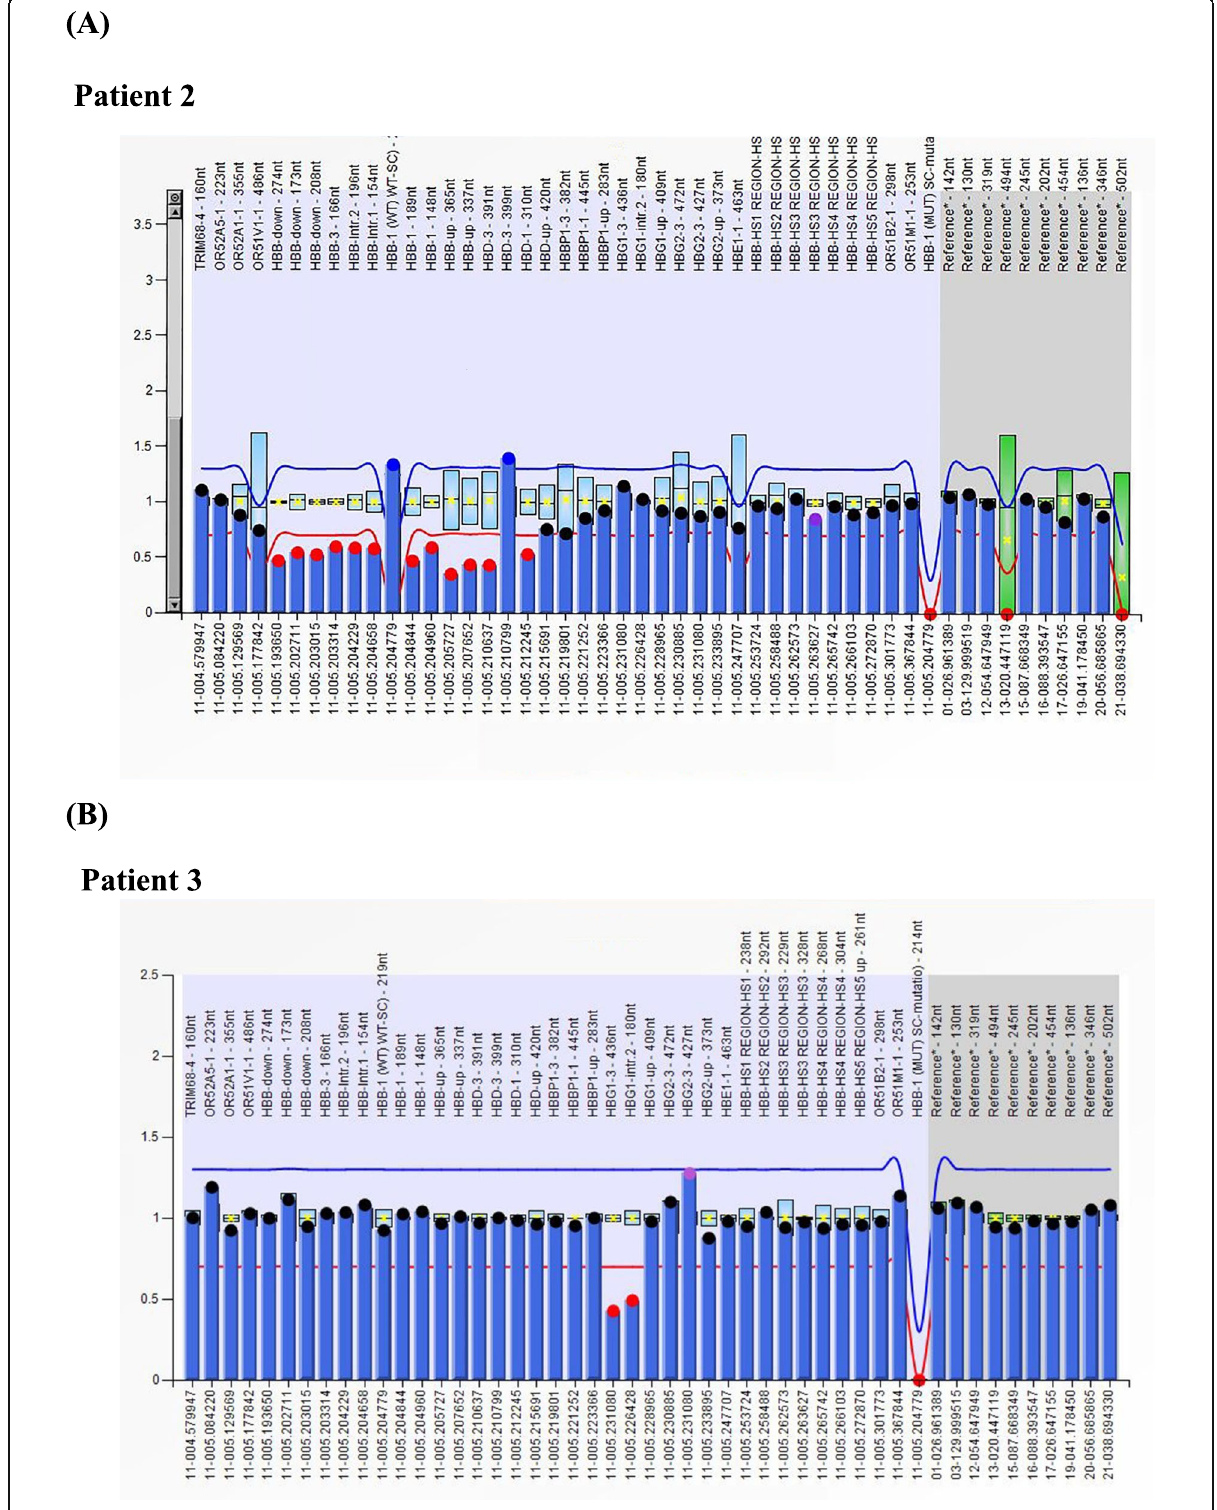
Fig. 7 ( a ) MLPA analysis showing half dosages for two probes located in HBG1 in patient 2 and fourteen probes located in the HBB and HBD region in patient 2; ( b ) MLPA analysis showing half dosages for two probes located in HBG1 in patient